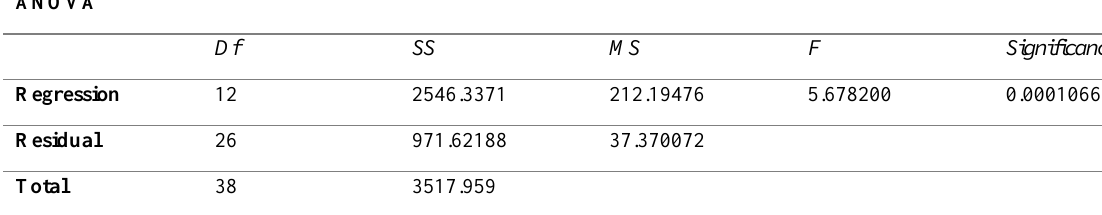
Table 26: ANOVA (Sylhet Division)